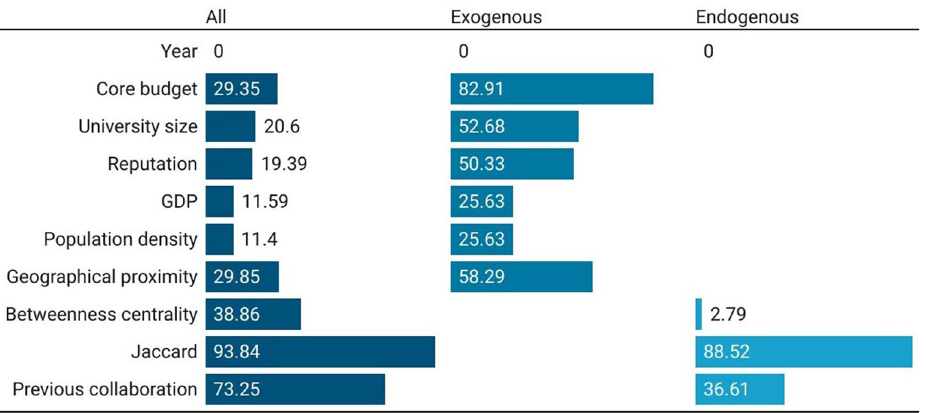
Figure 8. Feature-importance scores for European universities’ co-publication prediction in Multidisciplinary Science. Three models considered: with all, with only exogenous, and with only endogenous features. For convenience, features’ importance is averaged across years and universities to be better presented